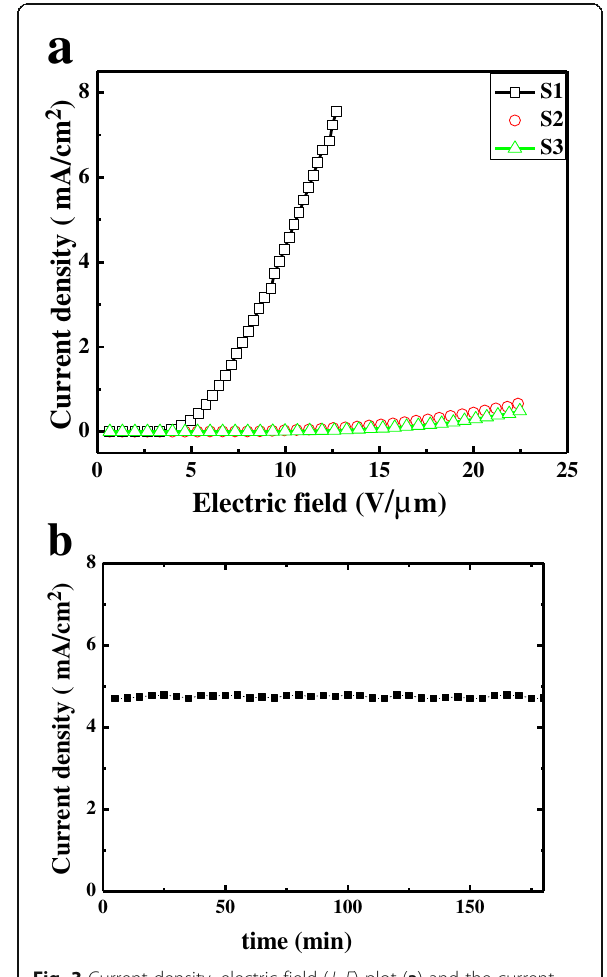
thickness were fabricated according to the same condition.